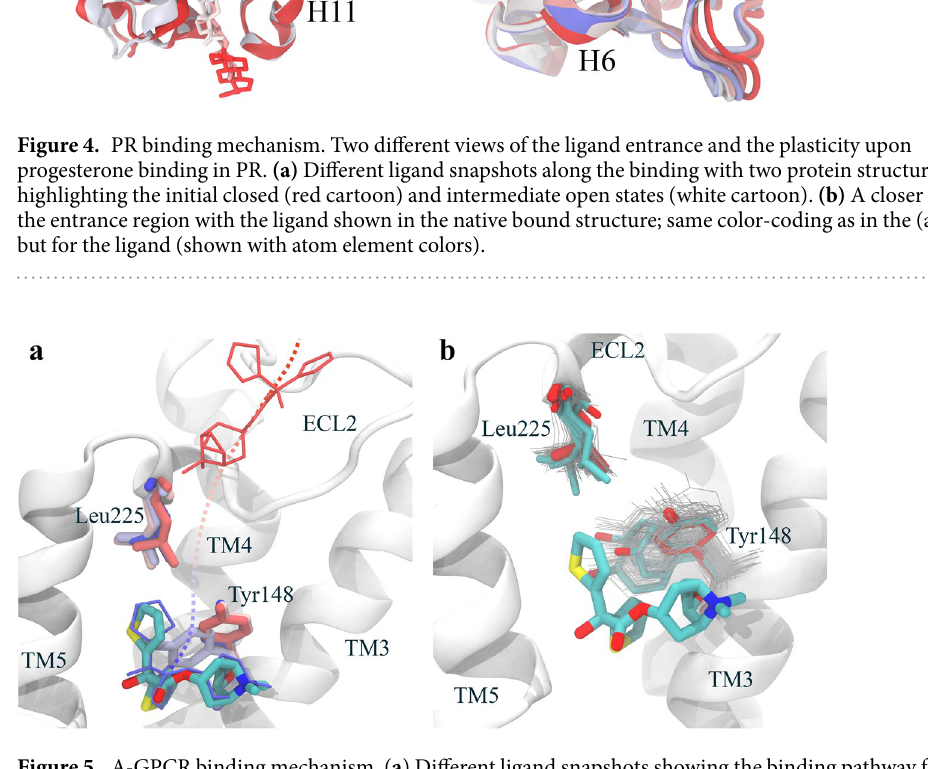
Figure 5. A-GPCR binding mechanism. ( a ) Different ligand snapshots showing the binding pathway from the initial structure (in red) to the bound pose (in blue), including Y148 and L225, which follow the same color- code. The white cartoon protein and the colored licorice ligand correspond to the bound crystal structure. (b) Side chain conformations for Y148 and L225, where the red licorice corresponds to the crystal structure. In grey lines, we show all the different conformations for those cluster centers along the adaptive process, and in colored licorice we show the resulting main conformations after a k-medoids